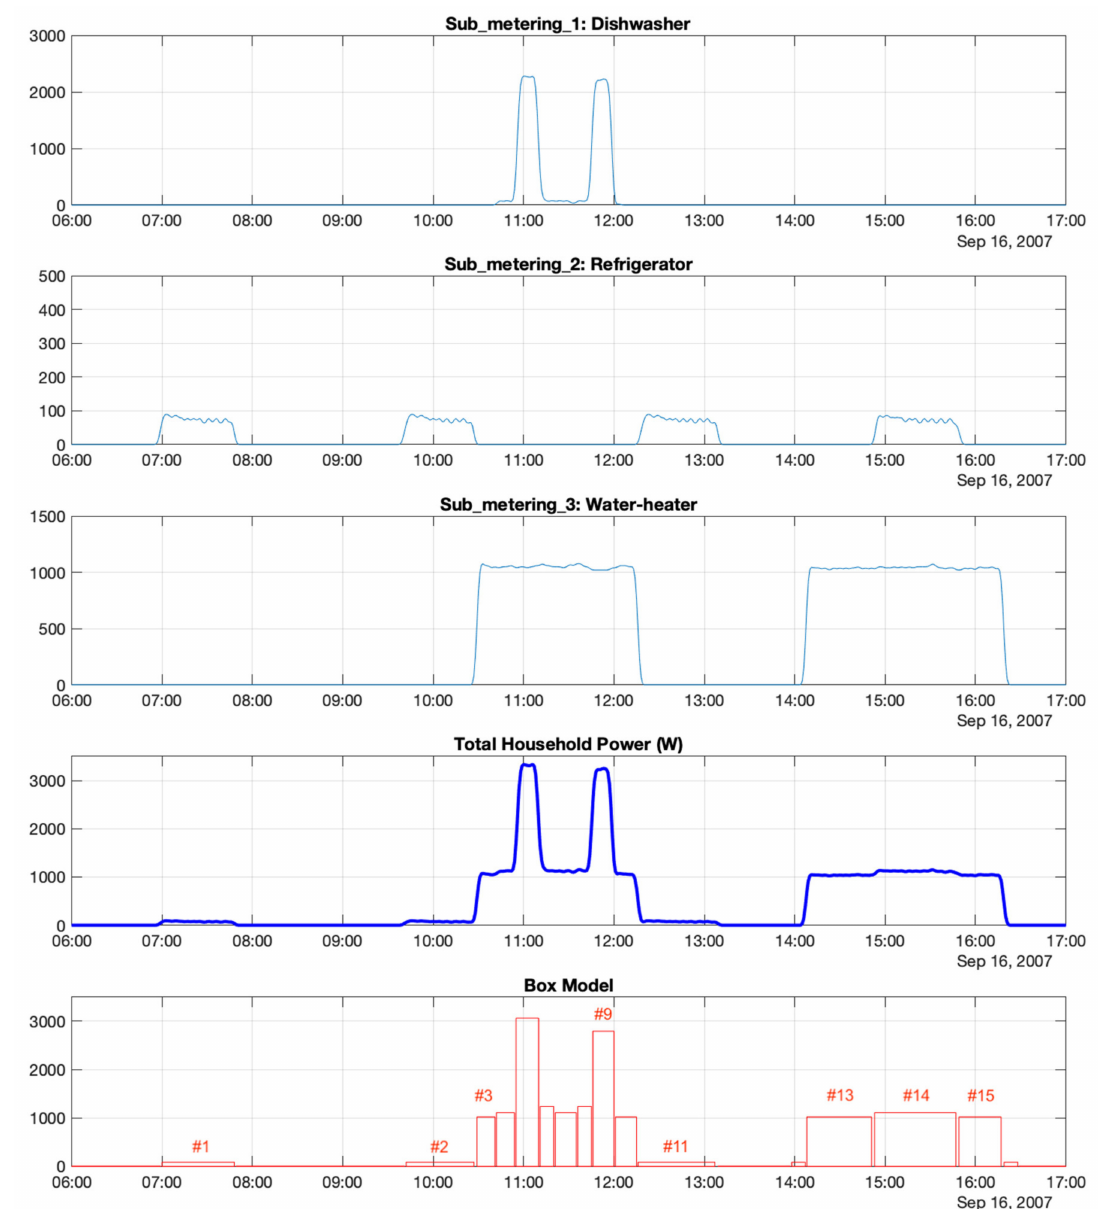
Figure 14. Box Model